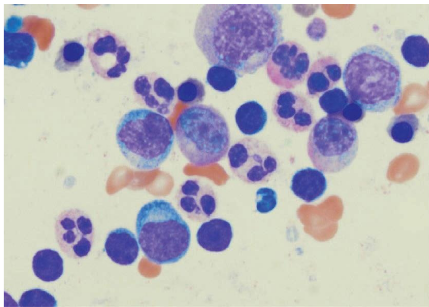
Figure 1: Bone marrow